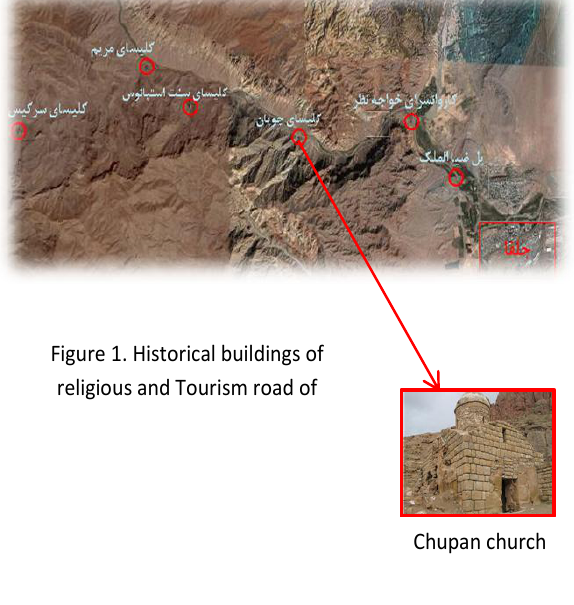
Figure 1. Historical buildings